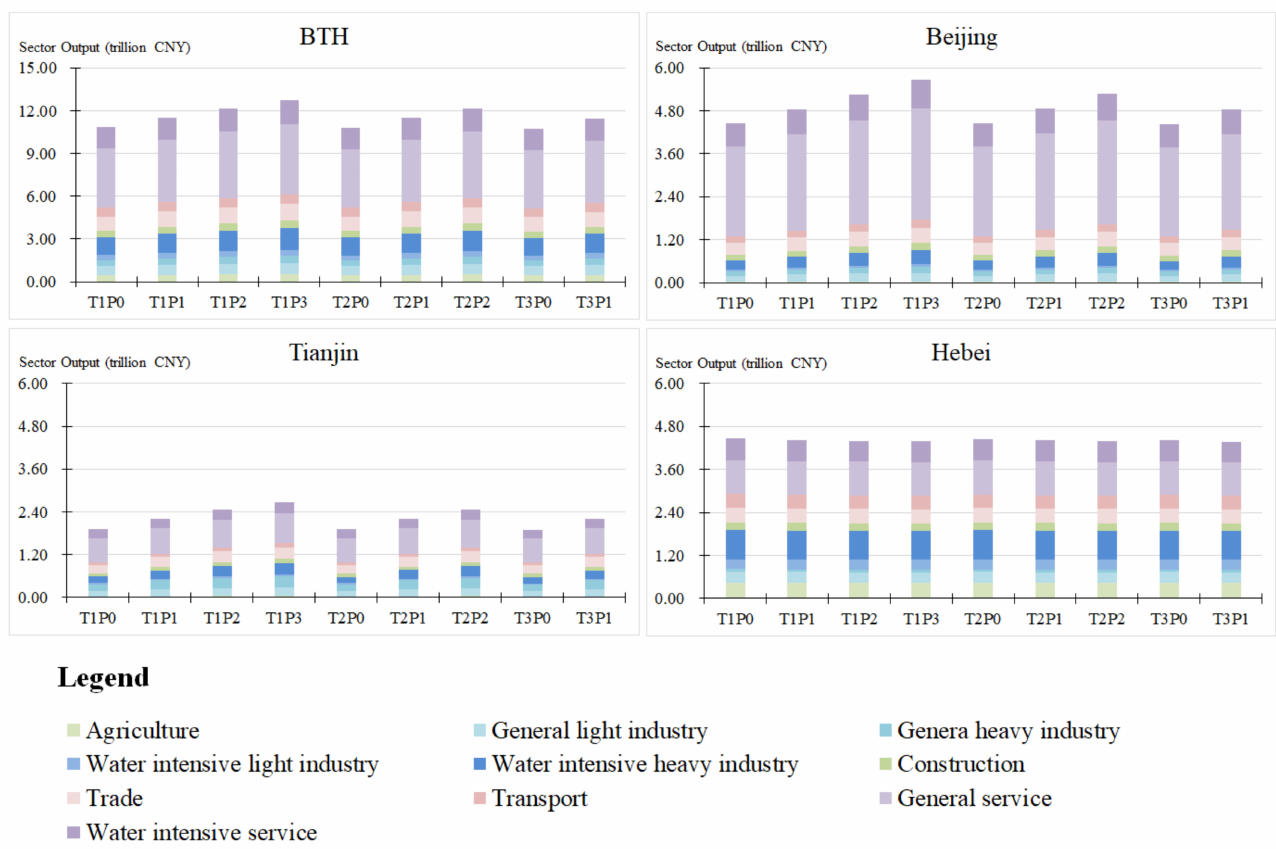
Figure 5. Sector output in different